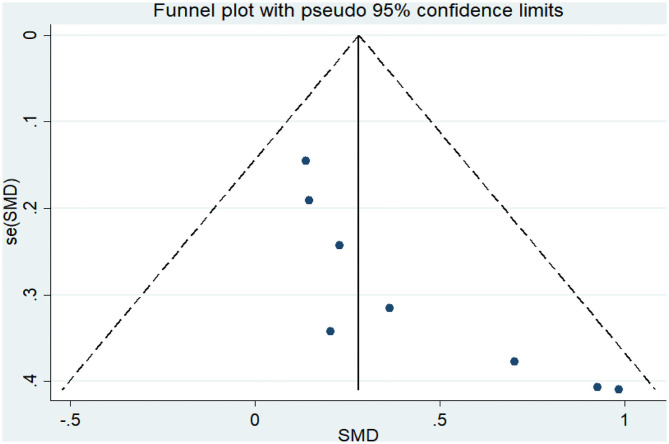
Funnel plot of publication bias for working memory.